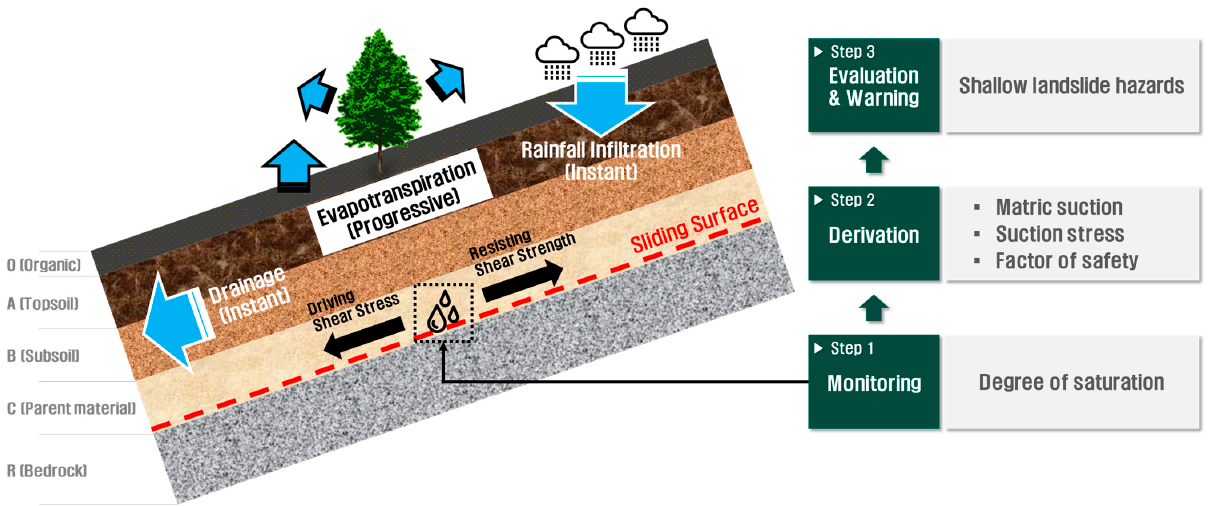
Figure 14. Cross-sectional scheme of the conceptual framework derived from the four-year monitoring study.